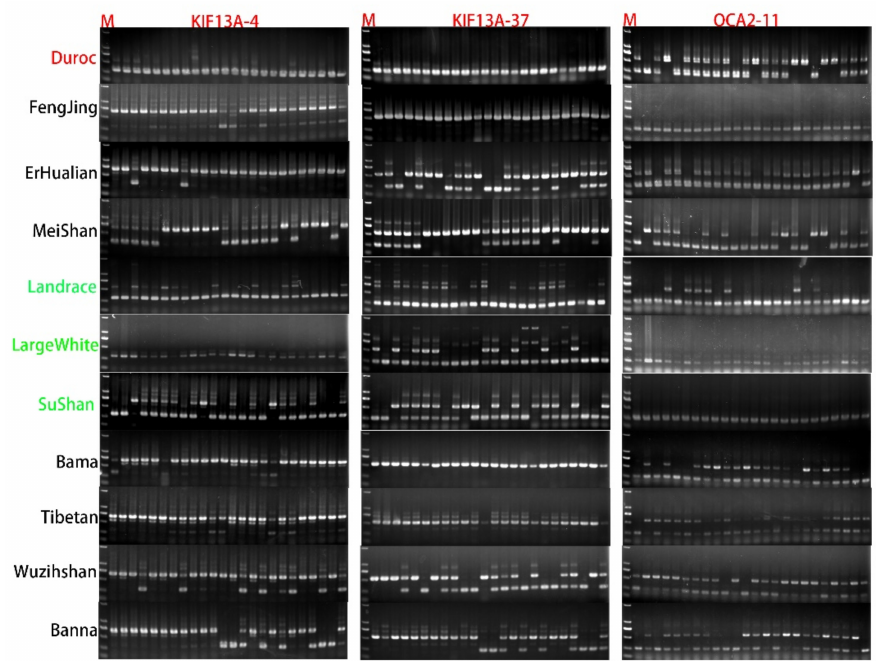
Figure 4. RIP-sites of KIF13A-4, KIF13A-37, and OCA2-11 detection in different small group pig breeds by PCR. M: Marker